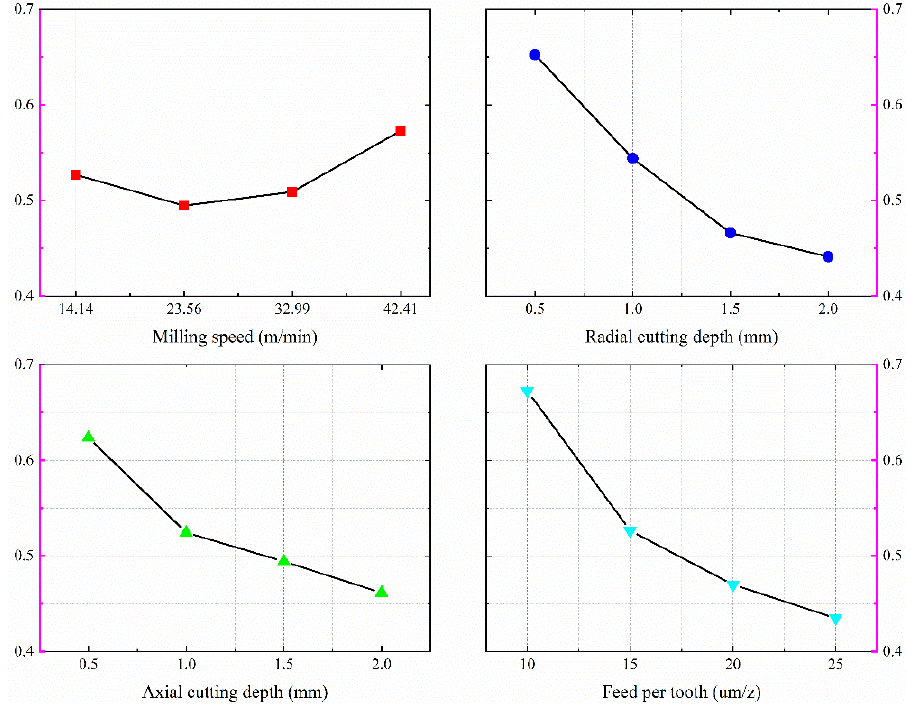
Figure 28. The mean main response for gray correlation.